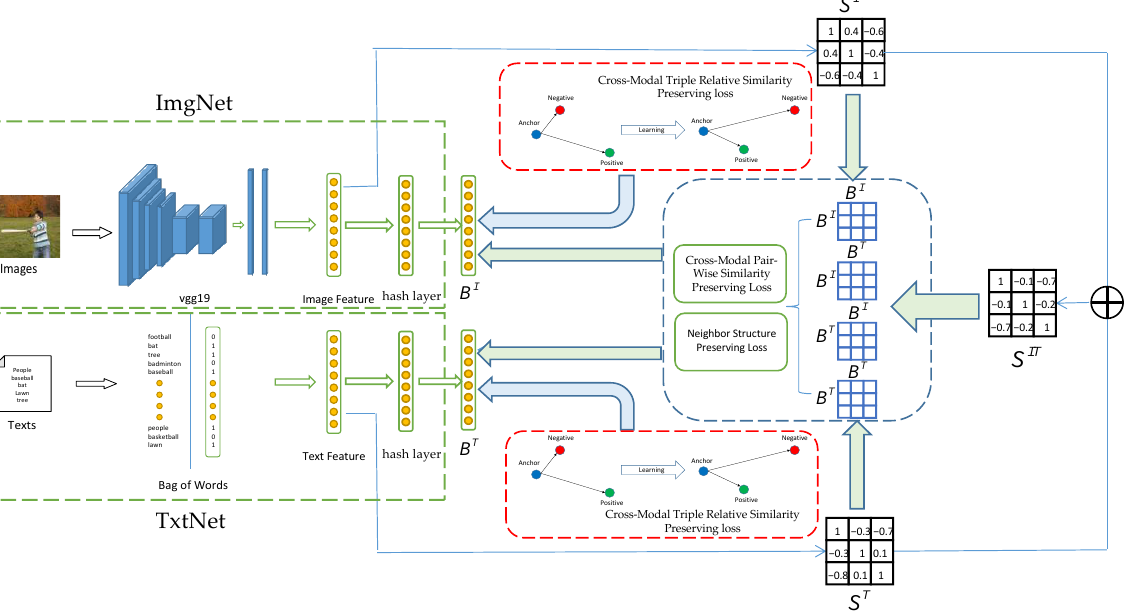
Figure 1. The framework of the unsupervised deep relative neighbor relationship that preserves cross-modal hashing. Table 1. The advantages of our proposed method compared with other similar